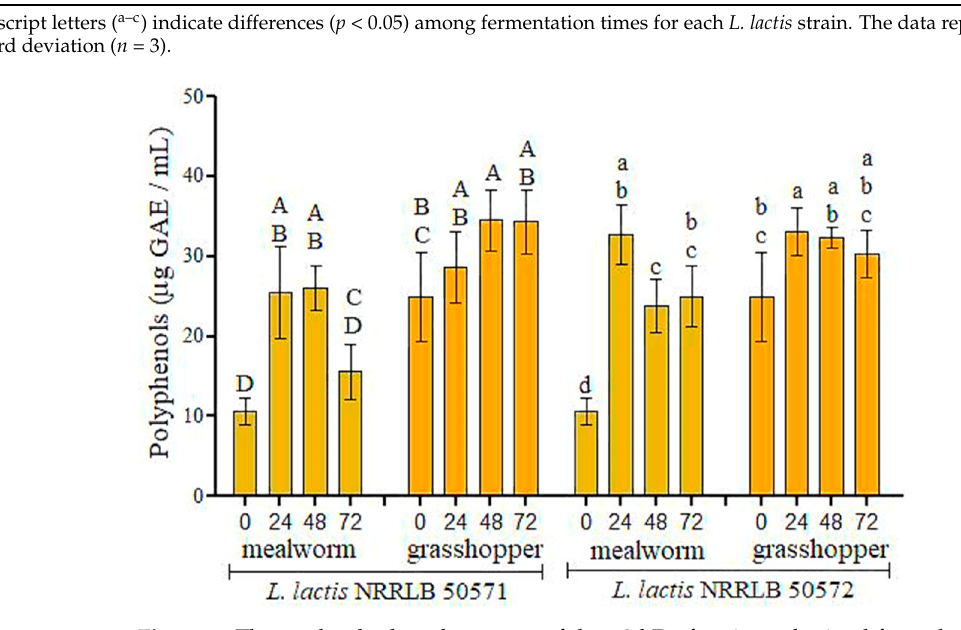
Table 4. The cell concentration of L. lactis strains during the fermentation processes of edible insect flour. Cell Concentration (CFU/mL)